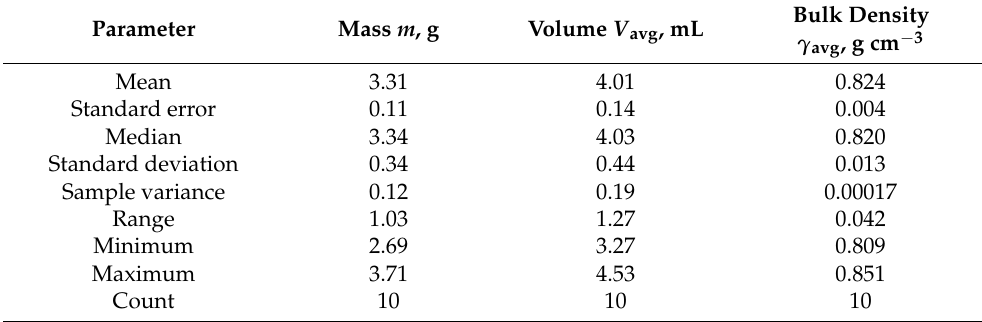
Table 5. The hundred-granule sample mass, volume, and bulk density for the Substral fertilizer.